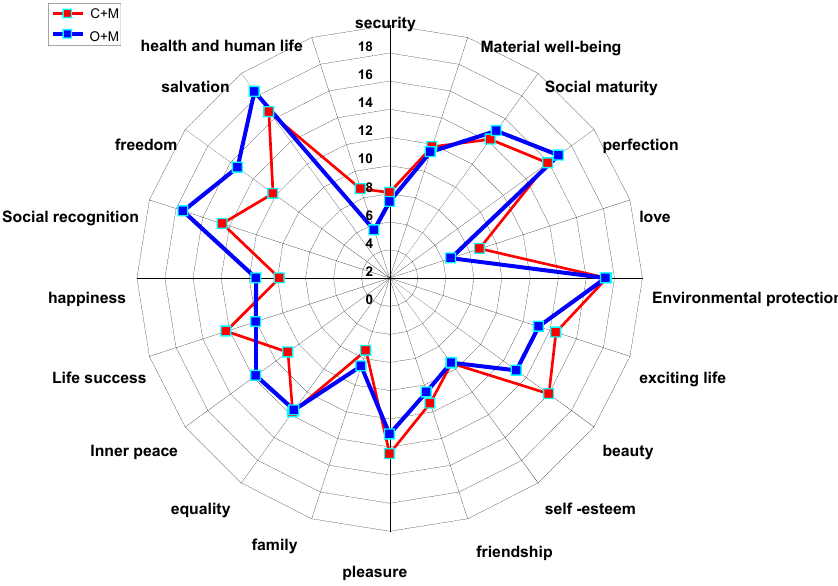
Figure 3. List of preferences of the terminal values of Catholic and Orthodox respondents from mixed Catholic-Orthodox families. Source: own study based on research results.